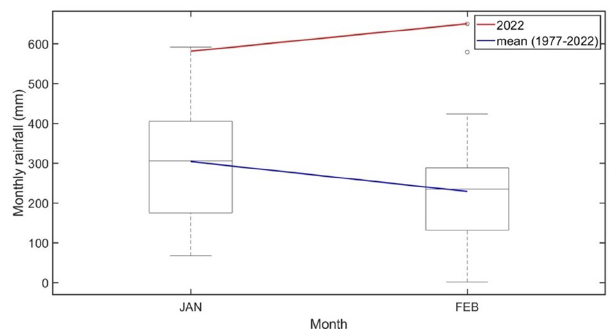
Figure 4. January and February rainfall (mm) distribution (boxplot) for 1977–2022. The blue line indicates the mean value for the 1977– 2022 period (for the months of January and February), and the red line represents the accumulated rainfall for 2022. Circles represent